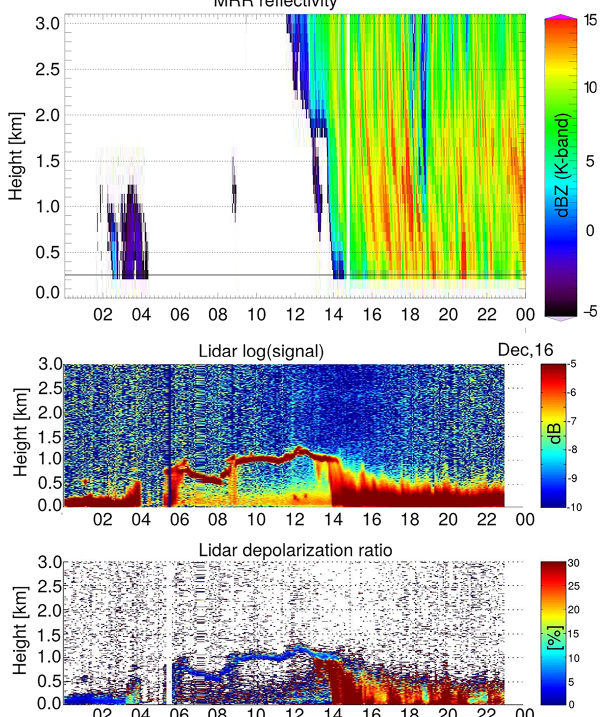
Figure 3. Example of a time series (time–height image) of MRR data and lidar data for the 15 December